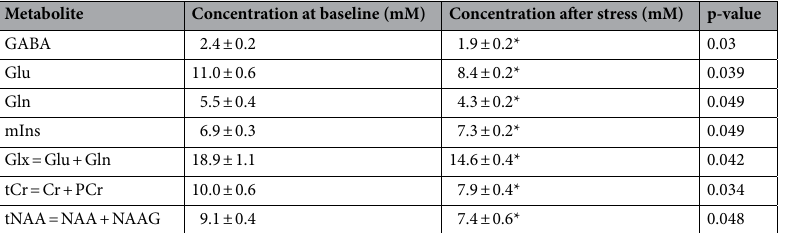
Table 3. The MRS-derived absolute concentrations of metabolites (mean ± SEM), which significantly changes after stress. GABA, Glu, Gln, Glx, tCr, and total NAA (tNAA = NAA + NAAG) decreased, while mIns increased under stress. *p <